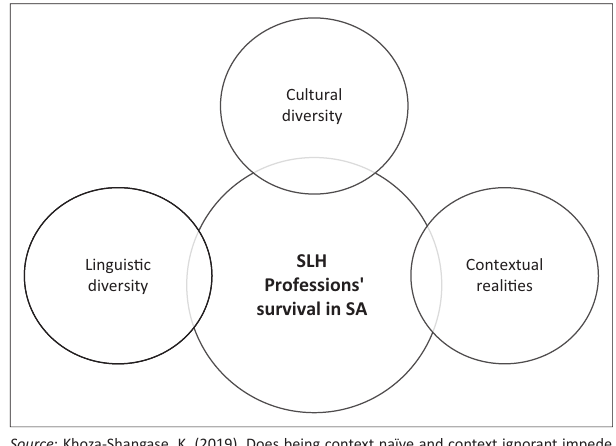
FIGURE 1: Tripartite threat to the survival of speech-language and hearing professions in South Africa.